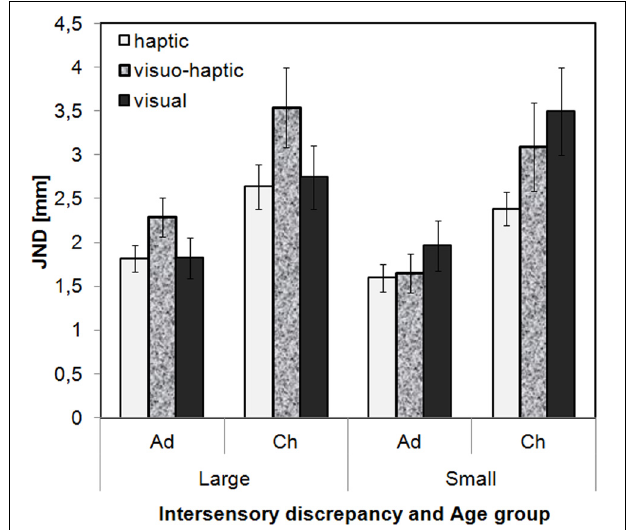
FIGURE 3 | Measured JND values and standard errors as a function of Modality, Intersensory discrepancy, and Age group (Ad[ults] vs. Ch[ildren]) averaged over the two conditions of Stimulus Set.